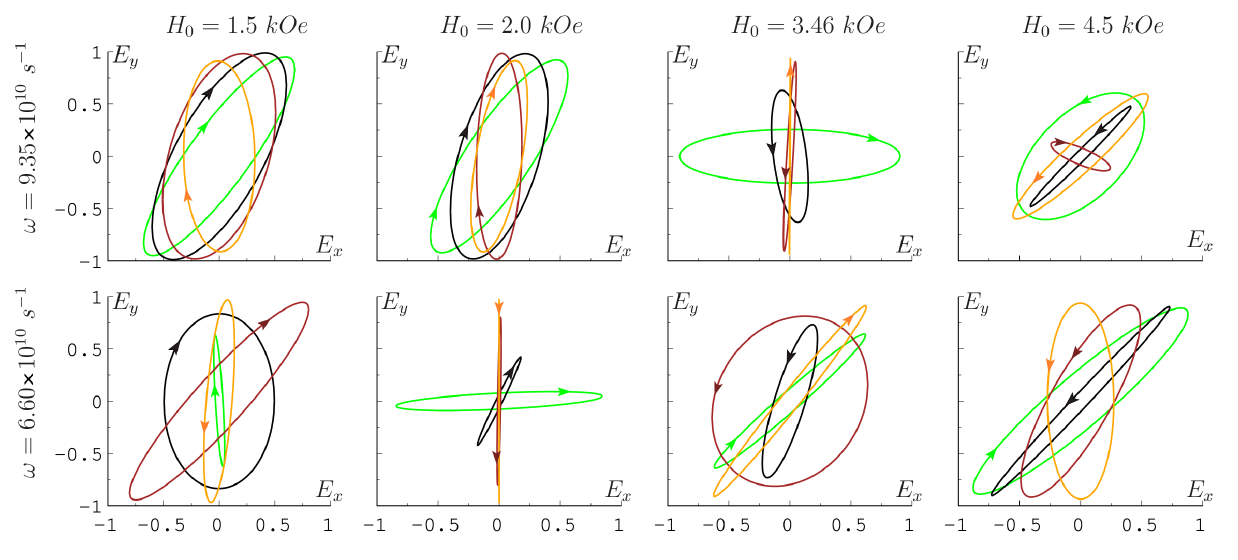
Figure 7. Polarization ellipses of the transmitted radiation at frequency ω = 6.6 × 10 10 s − 1 and ω = 9.35 × 10 10 s − 1 for various values of the field and parameter θ = 0.5, 1, 2, 10 (green, black, brown, and yellow) arrows show the direction of polarization clockwise and